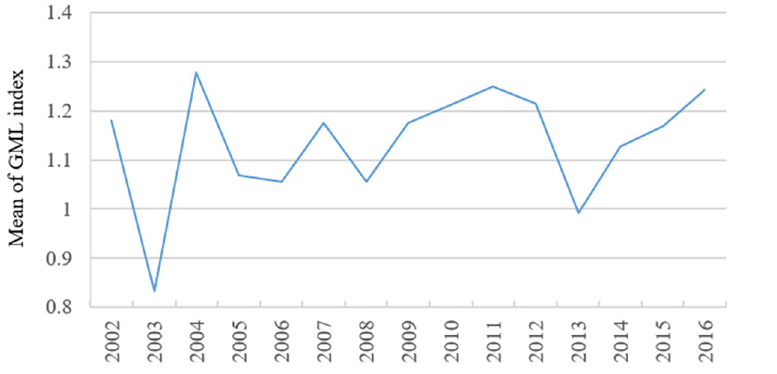
Fig 5. GML index change in tourism development of major cities in China in 2002–2016.